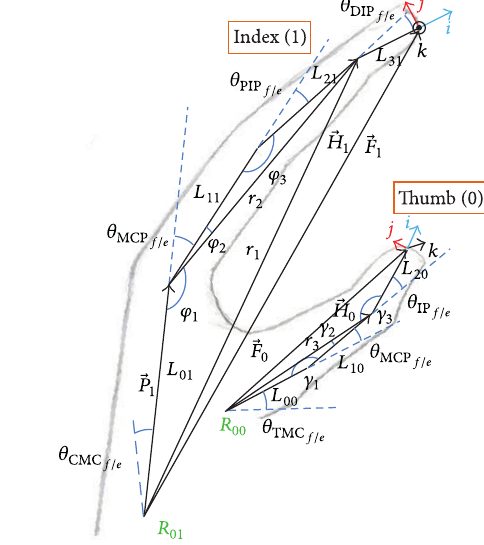
Figure 3: Inverse kinematics for the index finger and